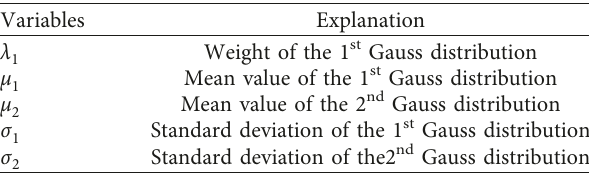
Table 4: Classification and explanation of output variables. Variables